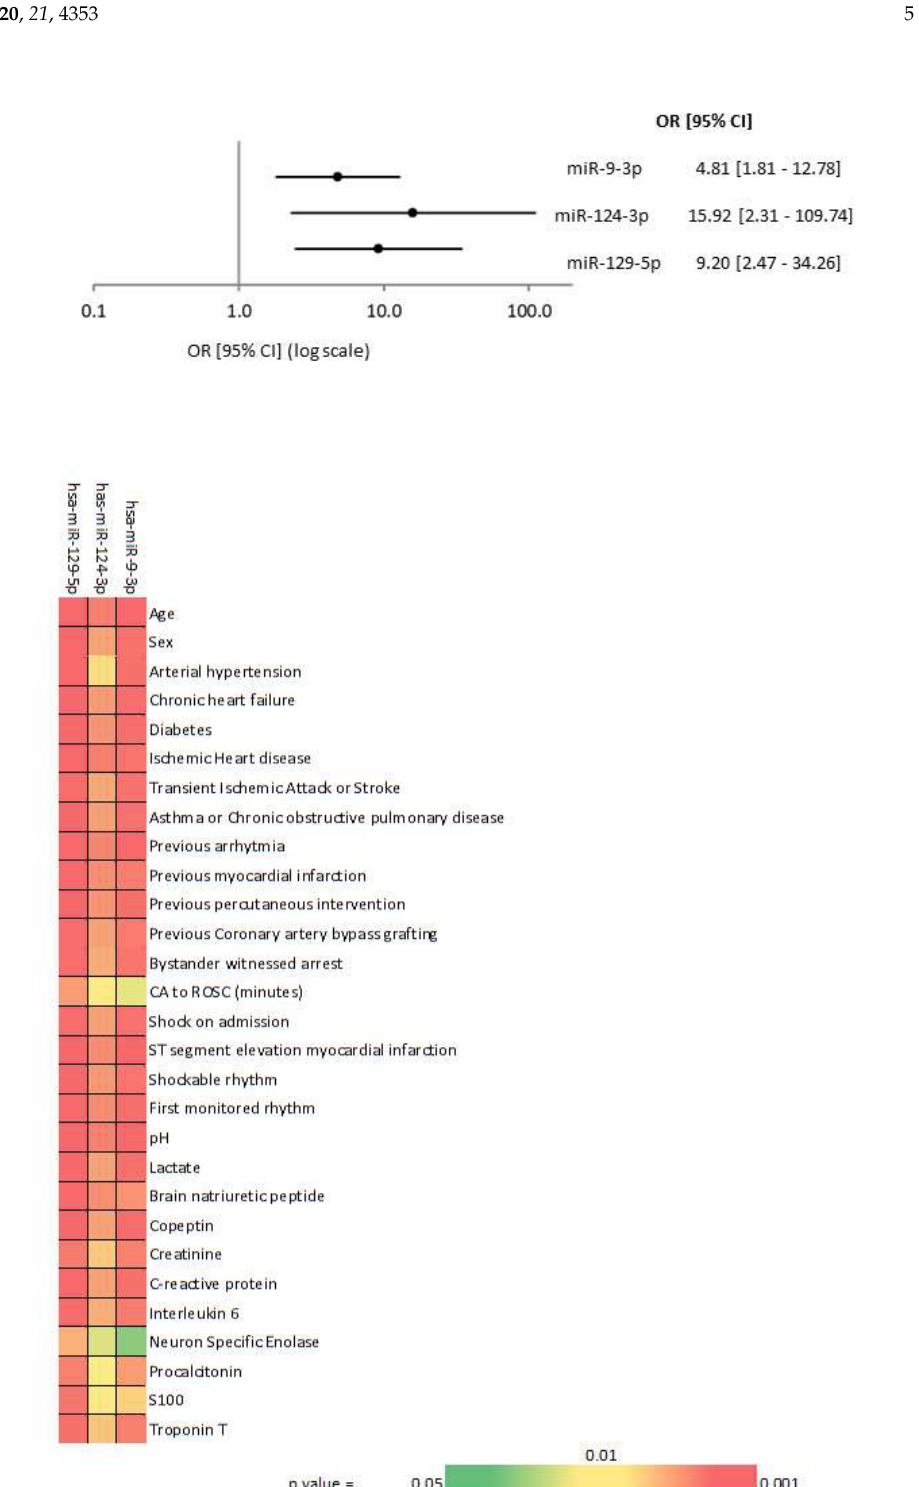
Figure 2. Association between miRNAs and neurological outcome. The association between levels of miR9-3p, miR124-3p and miR129-5p measured 48 h after ROSC in 50 patients and neurological outcome as attested by CPC score (1 vs. 5) at 6 months after cardiac arrest was addressed using univariate and multivariate logistic regression. ( a ) Forest plot with univariate odds ratios (OR) ± 95% confidence intervals (CI) for the prediction of neurological outcome. ( b ) Heat-map representing the statistical significance of multivariate logistic regression models containing one miRNA and one demographic or clinical variable. The coloured scale is as follows: p = 0.001 (red) and p = 0.05 (green), p = 0.01 being used as a middle point for the colour gradient. All values represented had a p -value below 0.05, and p -values below 0.001 were displayed as the maximum intensity of red.